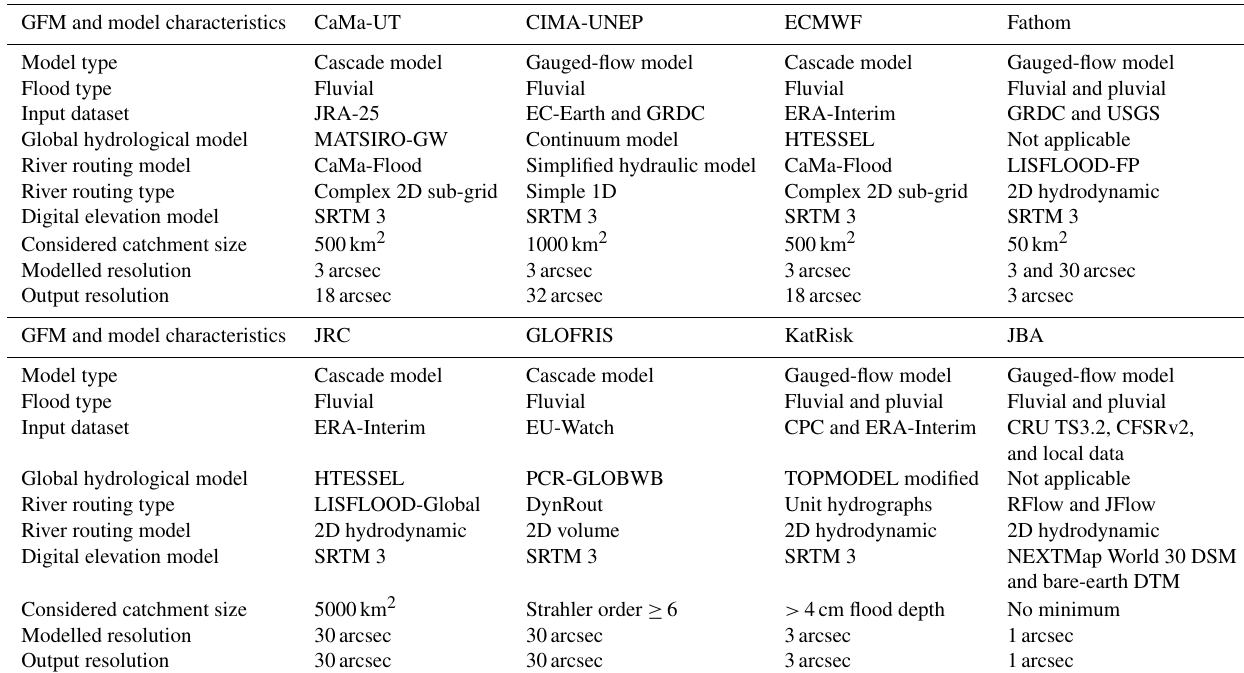
Table 2. Summary of the main model characteristics of the eight